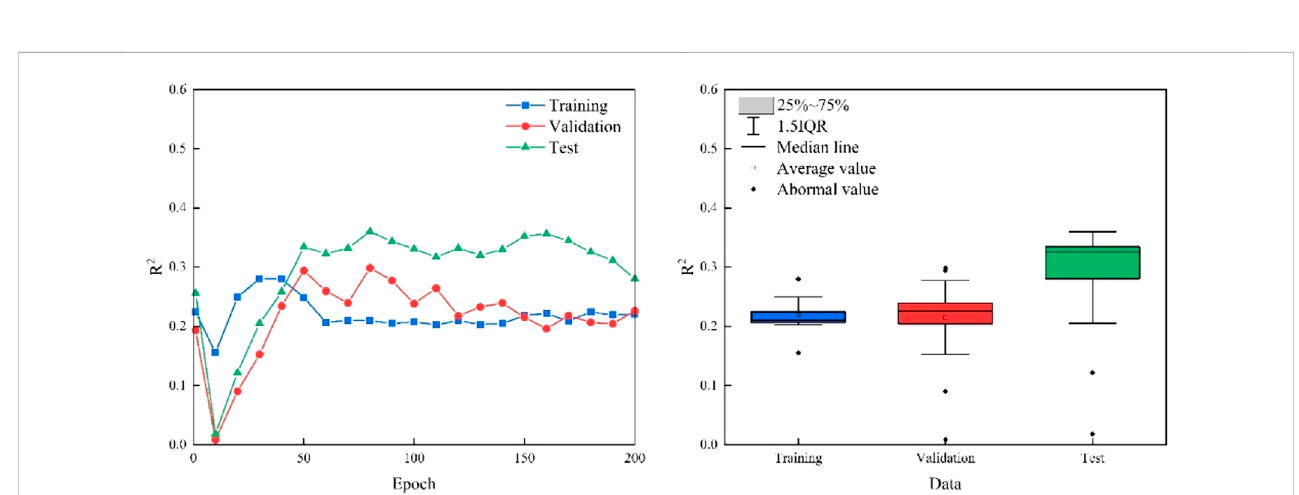
FIGURE 5 The coef fi cient of determination of the learning system at the training, validation, and testing stages with 200 epochs.